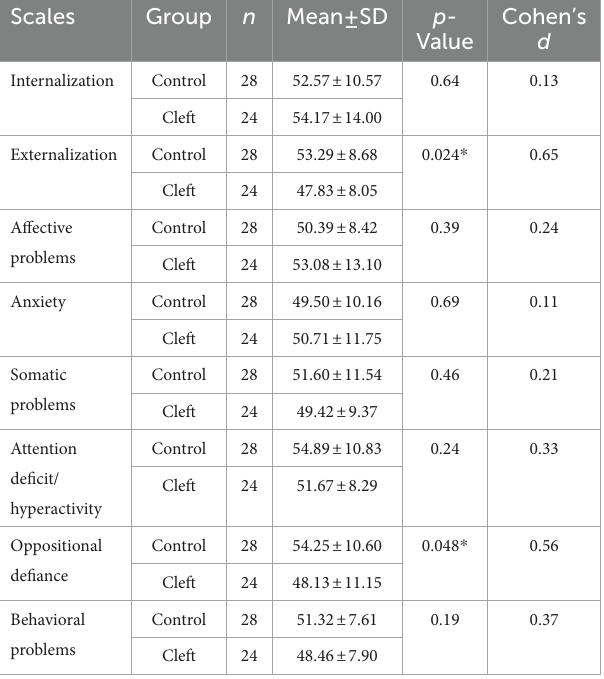
Table 5): Boys became potty-trained earlier (2.39 years) than girls